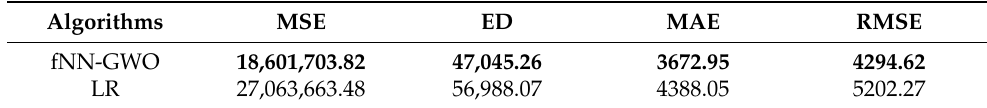
Figure 5. Error analysis of the hourly daily load consumption with fNN-GWO best results. The total daily load consumption results for fNN-GWO and LR can be found in Table 4. Similar to the previous experiments, the fNN-GWO outperforms the LR in all measures. The superiority of fNN-GWO compared to LR was better by 8,461,959.66, 9942.81, 715.1, and 907.65 for MSE, ED, MAE, and RMSE, respectively. The error analysis of the total daily load consumption for both methods can be found in Figures 7 and 8. Table 4. A comparison between fNN-GWO error forecasting results for total daily load consumption and